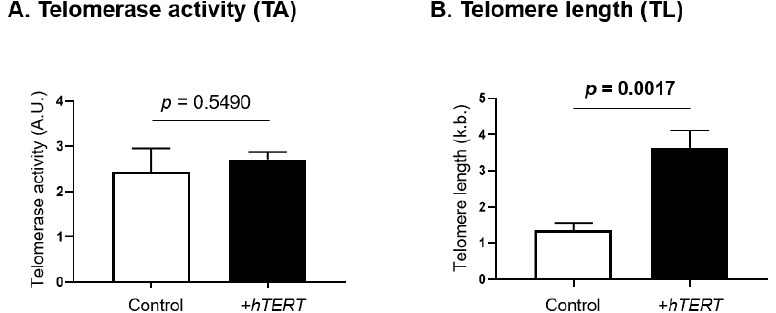
Figure 4. Functional impact of hTERT overexpression on telomerase activity and telomere length. Telomerase canonical functions were evaluated in SS cells overexpressing hTERT, through the assess- ment of ( A ) telomerase activity and ( B ) telomere length. Statistical analysis results are displayed on each graph. Significance level: p = 0.05.